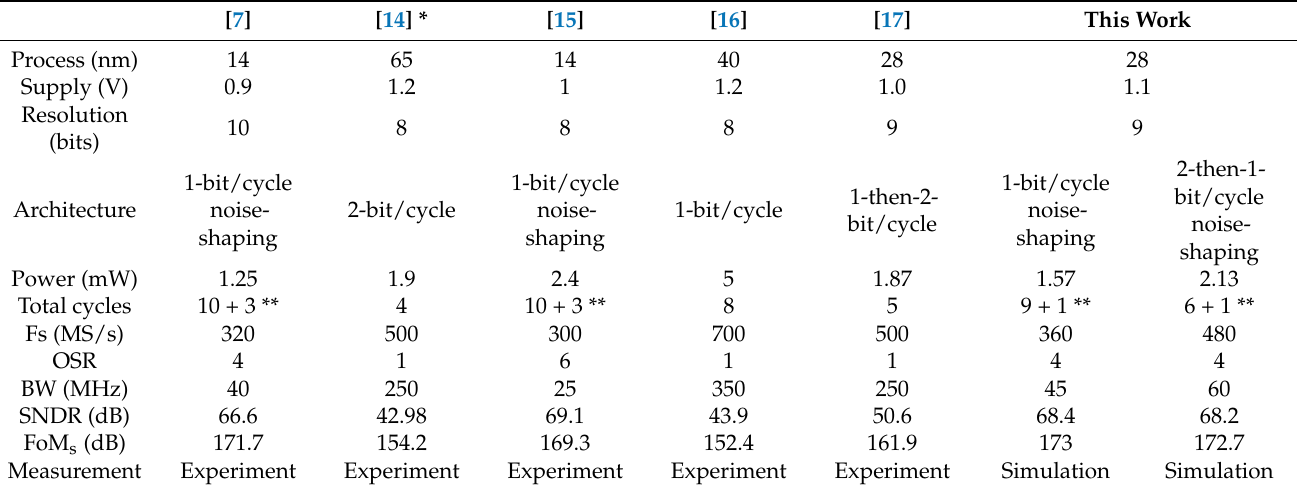
Table 1. Performance summary and comparison with prior